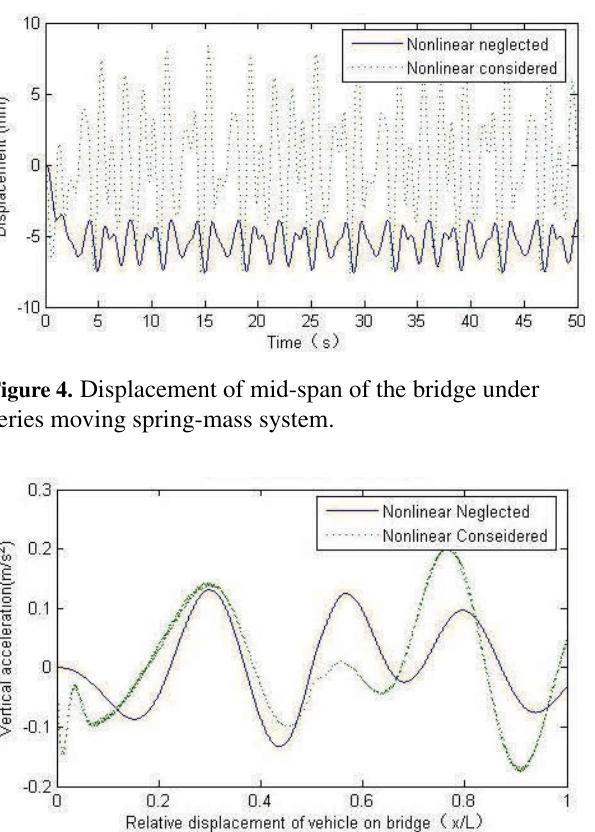
Figure 5. Vertical accelerations of the vehicle passing